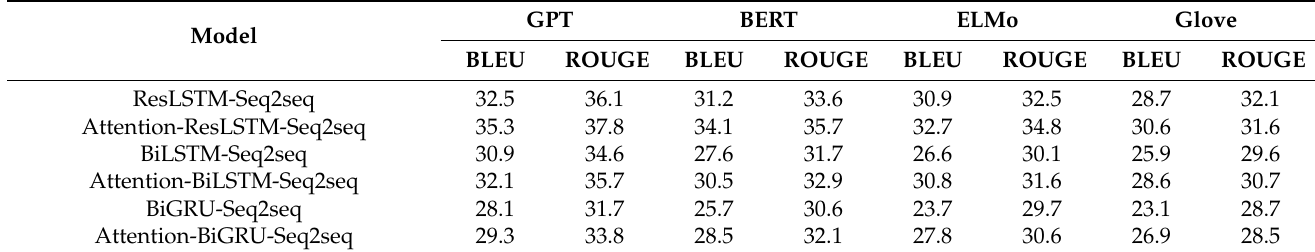
Table 8. BLEU and ROUGE of six models under different text vector presentation